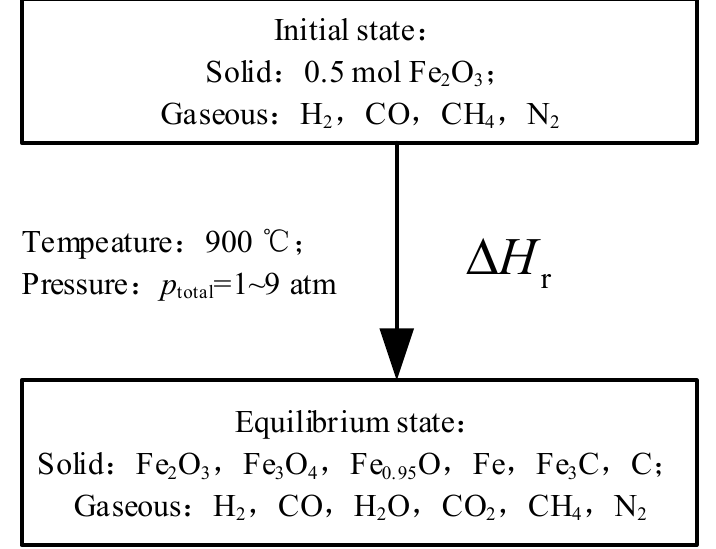
Figure 1. The initial and equilibrium state of the reaction system.